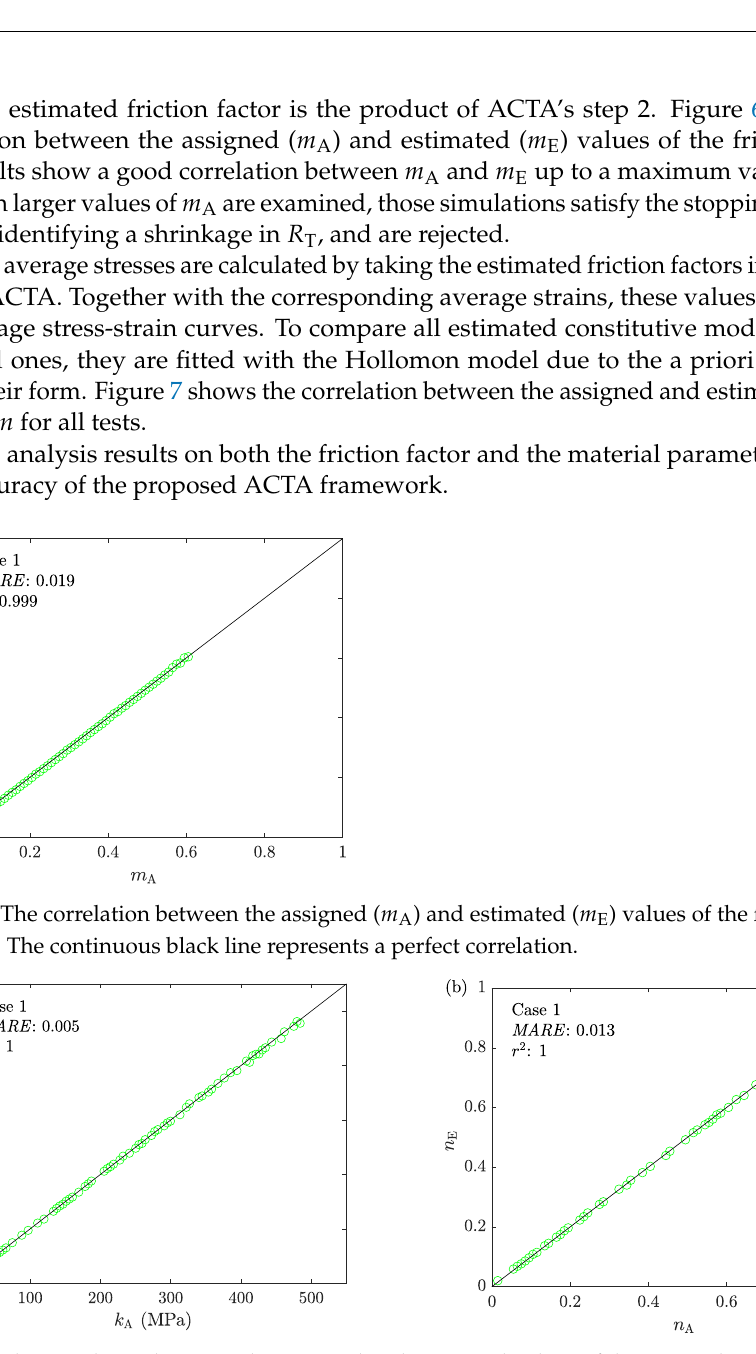
Figure 7. The correlation between the assigned and estimated values of the material parameters ( a ) k and ( b ) n in Case